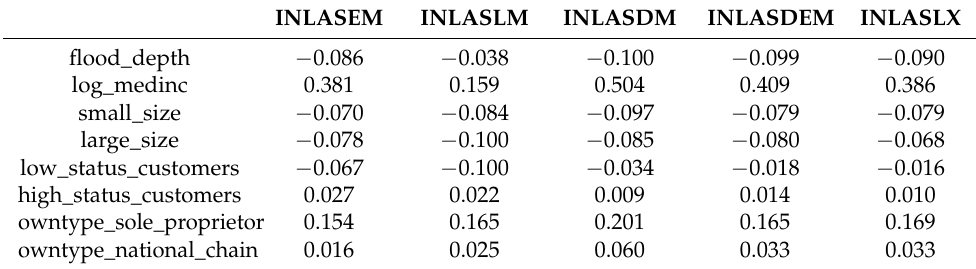
Table 4. Direct impacts, Katrina data